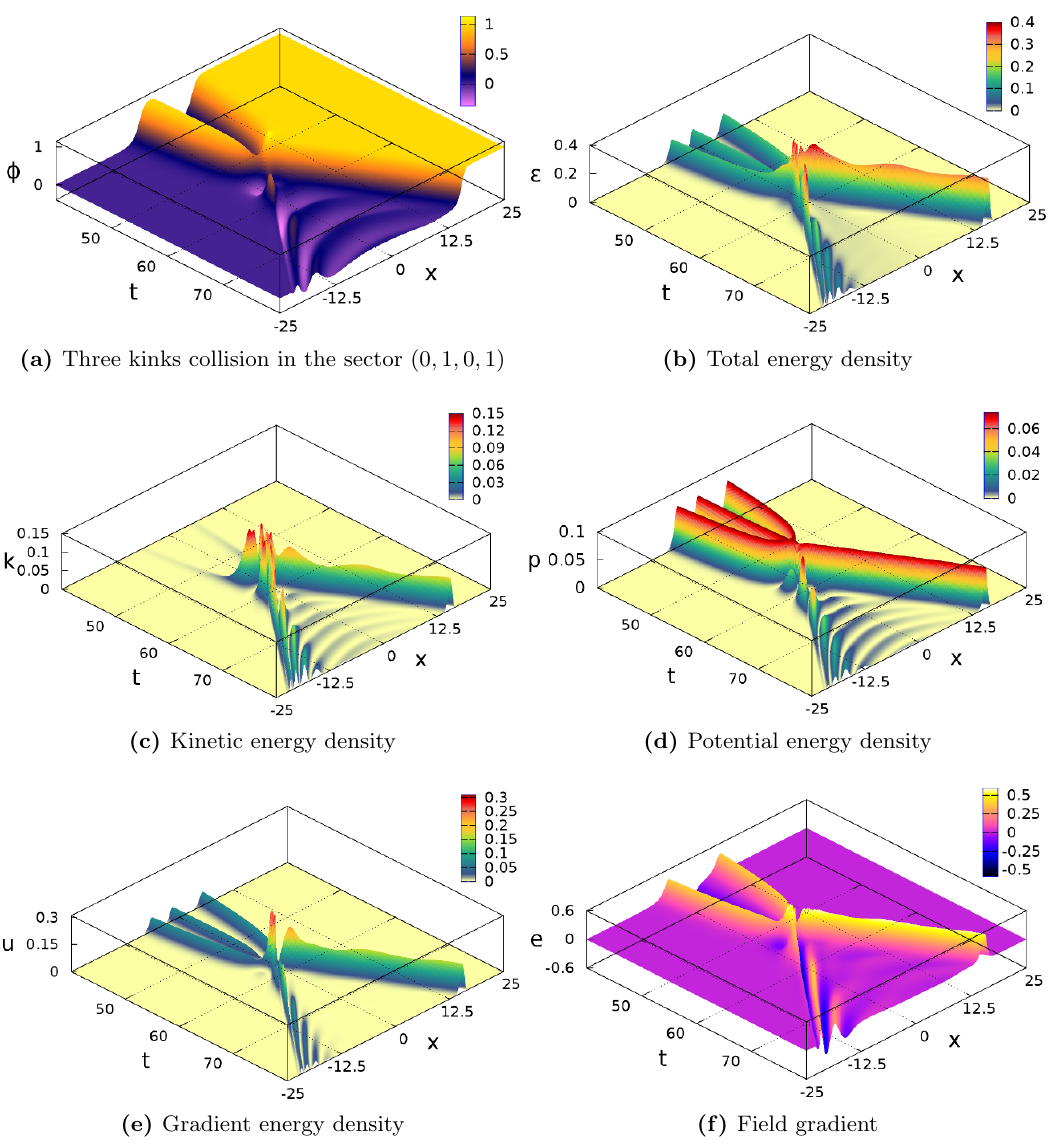
Figure 5. Space-time picture of collision of three kinks in the case of initial con(cid:12)guration (0 ; 1 ; 0 ;